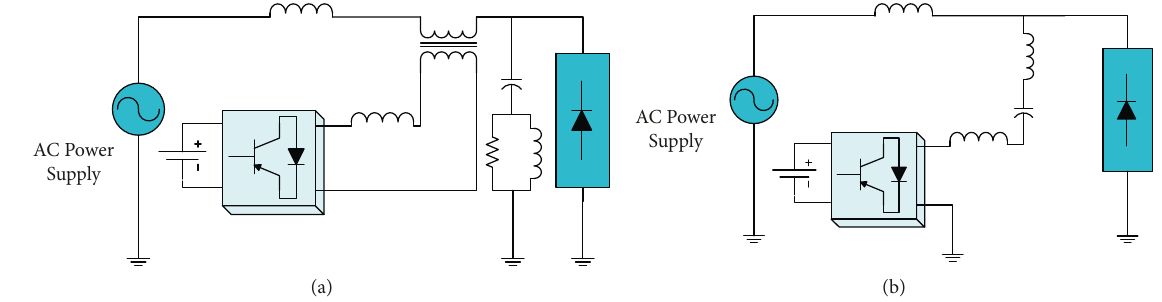
Figure 7: HAPFs (a) Configurations of SeAPF and SAPF and (b) Configurations of SAPF and SPPF.